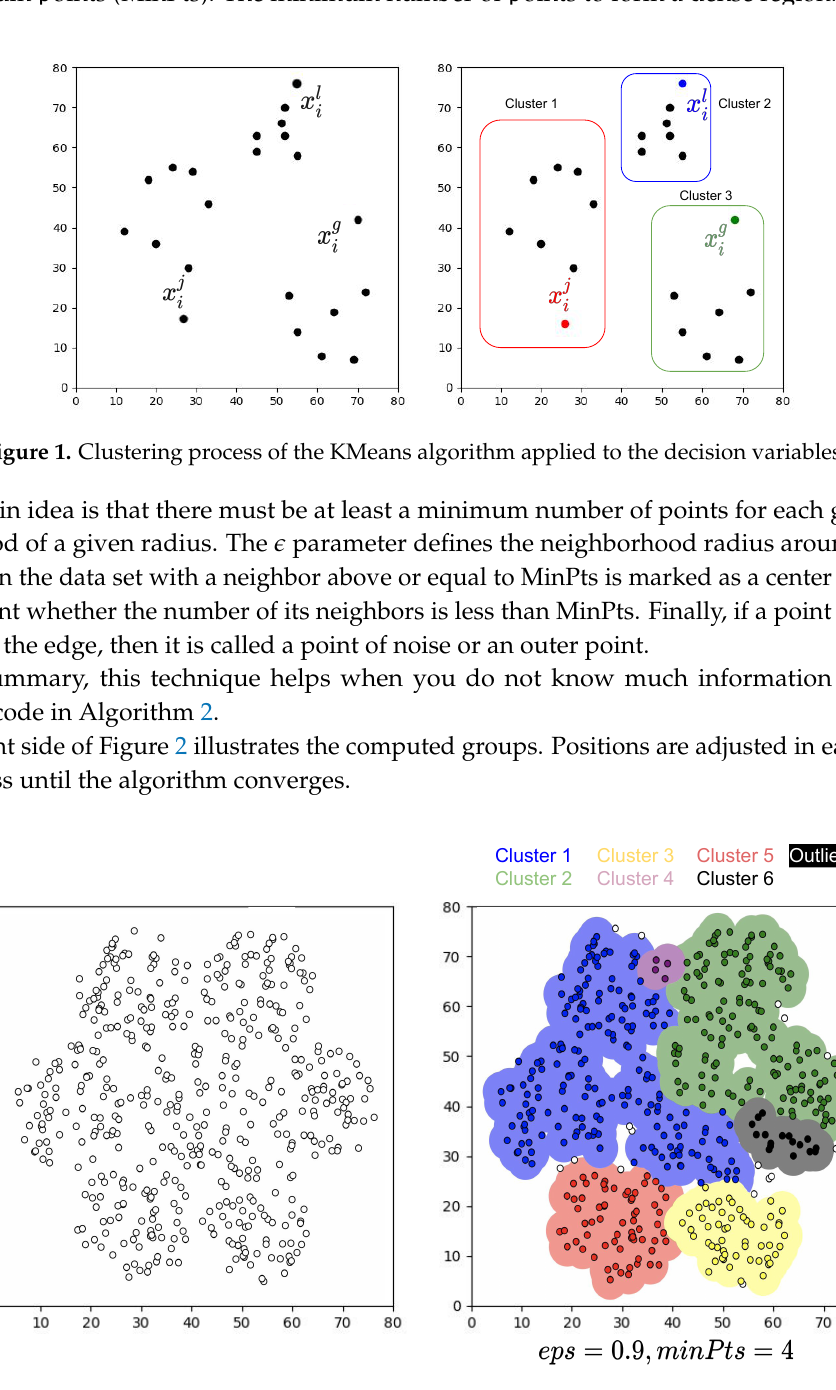
Figure 2. Clustering process of the DBscan algorithm applied to the best